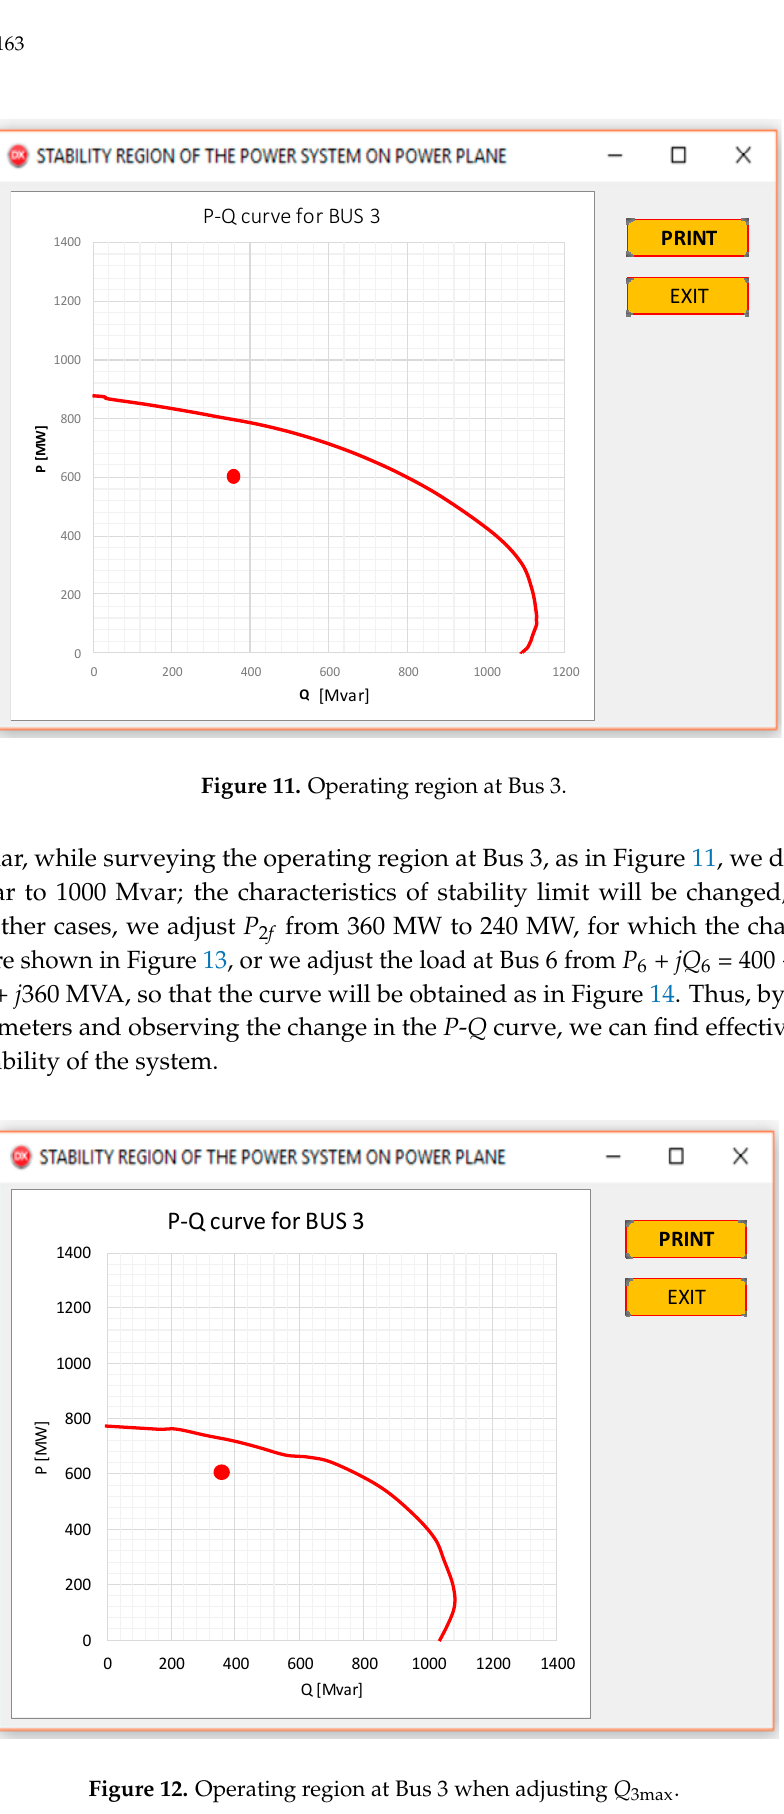
Figure 10. Operating region at Bus 6.